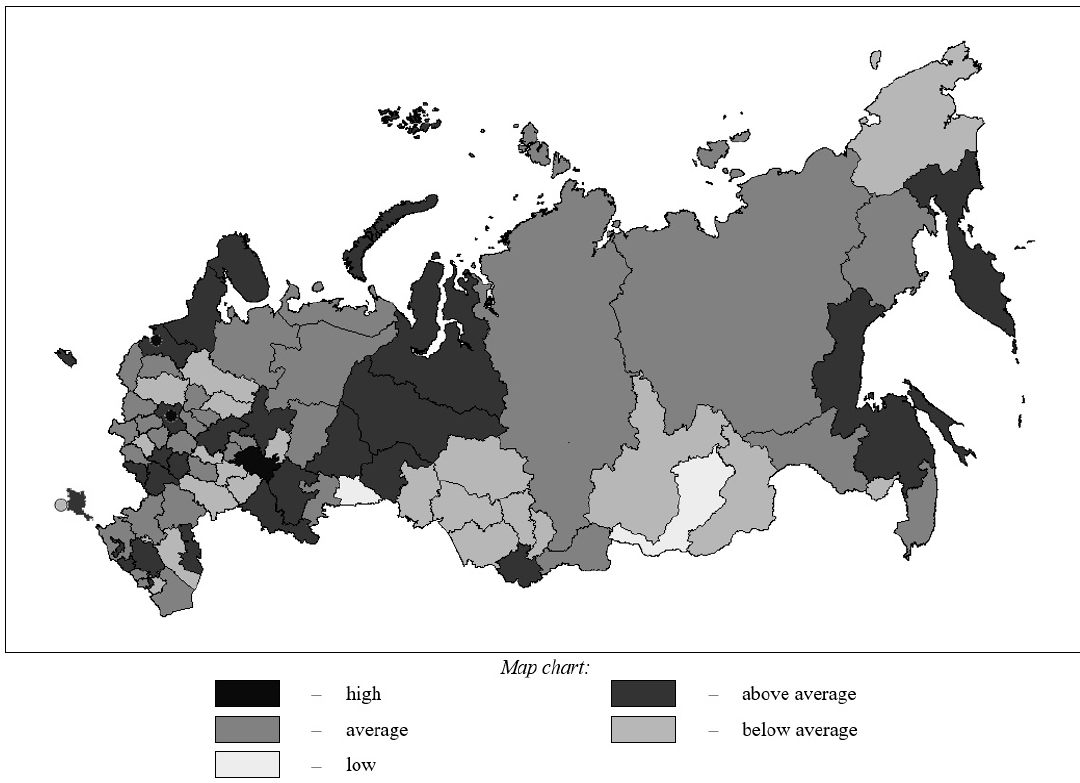
Figure 4. Level of digitalization in federal subjects of Russia in 2017.